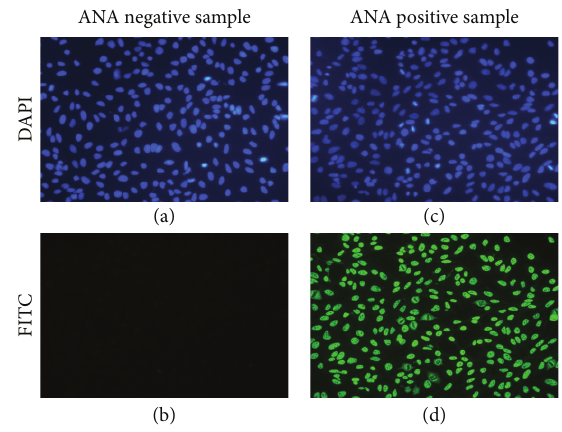
Figure 1: Examples of captured images. Examples of images obtained by IIF on HEp-2 cells from 2 different serum samples: one ANA negative ((a), (b)) and one ANA positive ((c), (d)) for both DAPI ((a), (c)) and FITC ((b), (d)) stainings. Objective: × 20. in Tagged Image File Format (TIFF) for subsequent analysis.